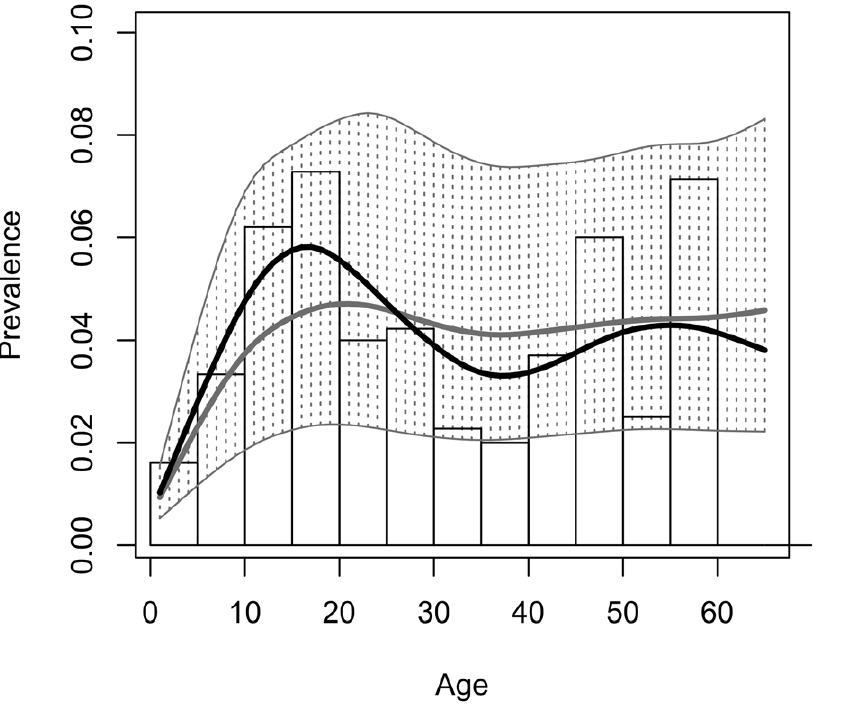
Figure 4. The observed and predicted relationship between age and prevalence of Trypanosomacruzi infection in Guadalupe, Arequipa, Peru. The histogram represents the observed data; a smoothed spline, weighted by the number of observations at each age, is fit to these data (black curve). Model estimates of the relationship between age and prevalence were calculated by determining the probability of infection for each individual derived from the posterior predictions of the epicenter regression model with four epicenters. The spline fit to the median posterior predictions is surrounded by a region bounded by splines fit to predictions from the 2.5% and 97.5% quantiles of the posterior (light grey, shaded).